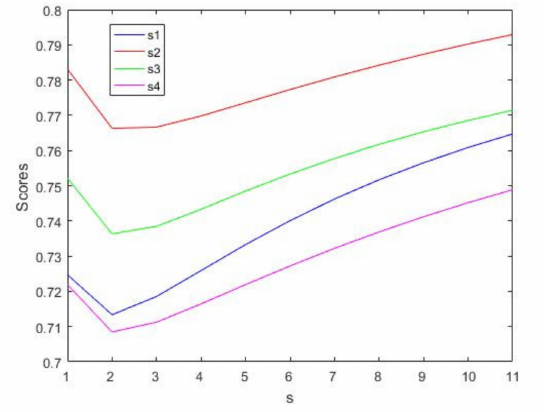
Figure 8. t = 1, s ∈ [ 1, 11 ]